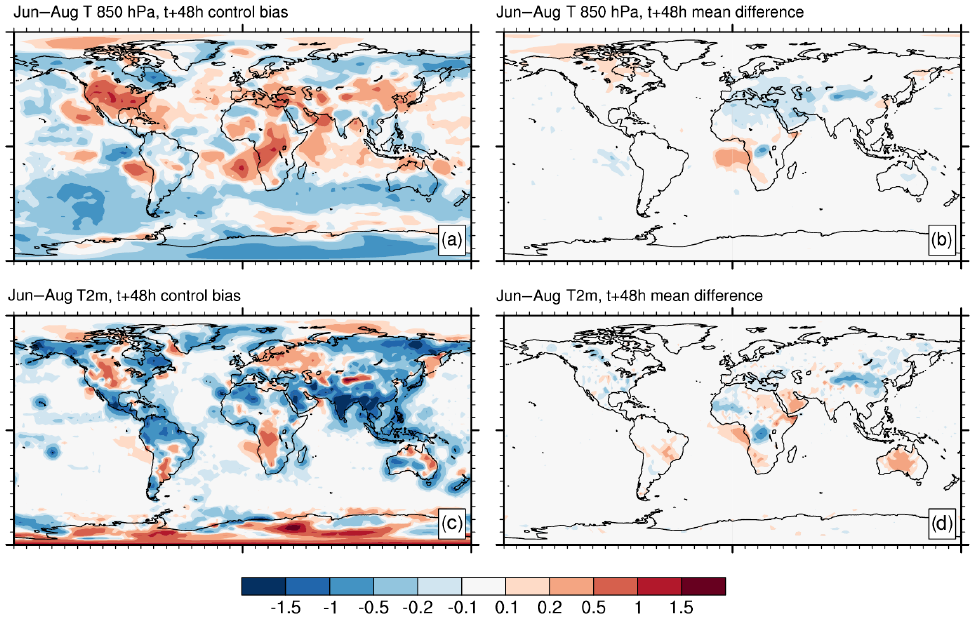
Figure 10. Temperature at 850hPa (in kelvin; a , b ) and 2m (in kelvin; c , d ) for forecast time t + 48h averaged during the 2-month period July–August 2016. Panels (a) and (c) show the error of the operational model, and (b) and (d) show the difference between a forecast experiment with CAMS climatology and the operational model using TG97. Model errors are computed against operational